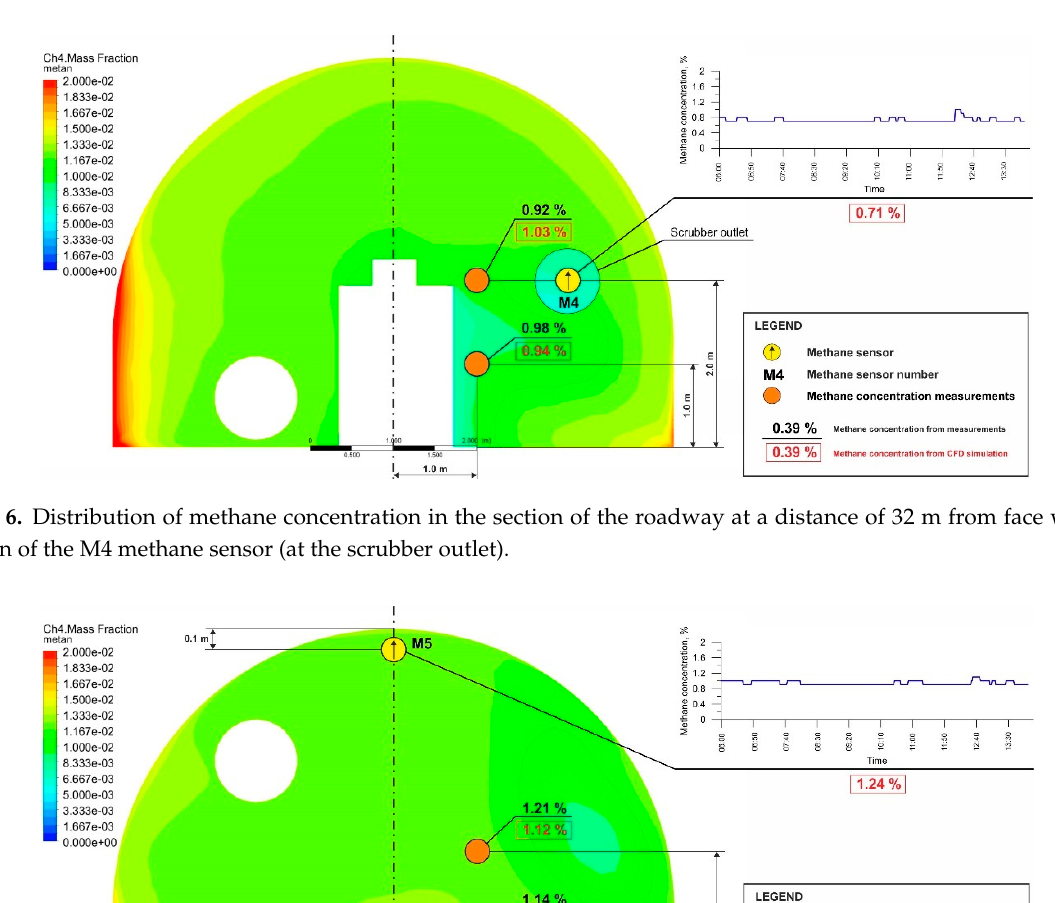
Figure 5. Distribution of methane concentration in the roadway’s section at a distance of 22 m from face and the location of the M3 methane sensor (cross-section at a setback distance of 2 m from the whirl-flow air duct).